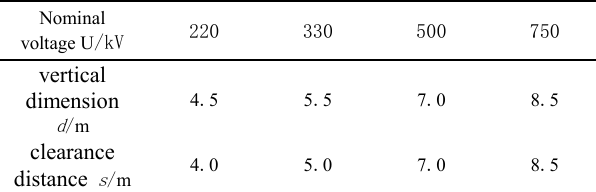
Figure 4. Grid elevation segmentation